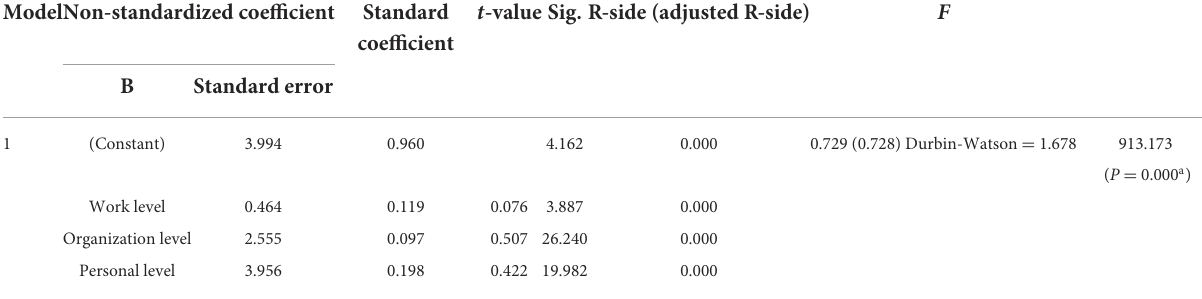
TABLE 7 Multiple linear regression analysis of three dimensions of burnout among prison officers.